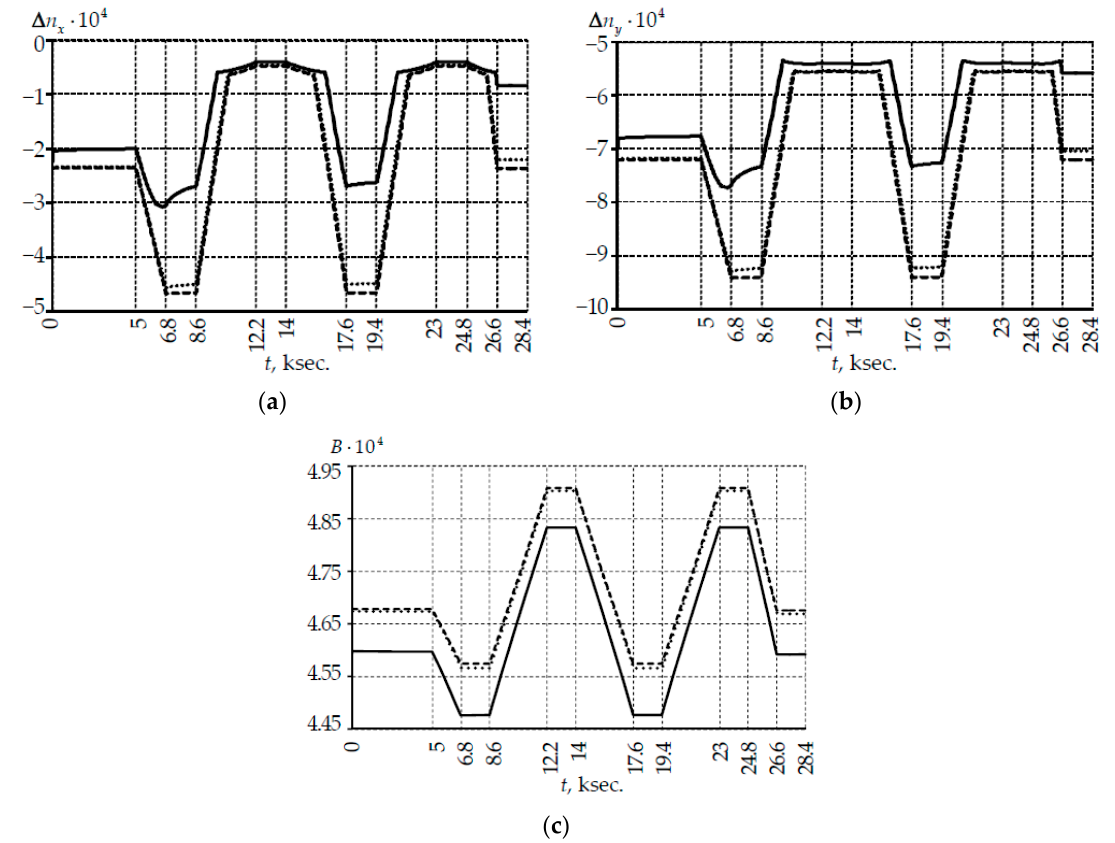
Figure 5. Influence of coil radius and bending on the optical parameters of fiber: ( a , b ) are deviations of the refractive indices in the light-conducting core center along the x and y axes, respectively; ( c ) is modal birefringence; solid line is R coil = 5 mm; points is R coil = 22 mm; dotted line is R coil = 50 mm.